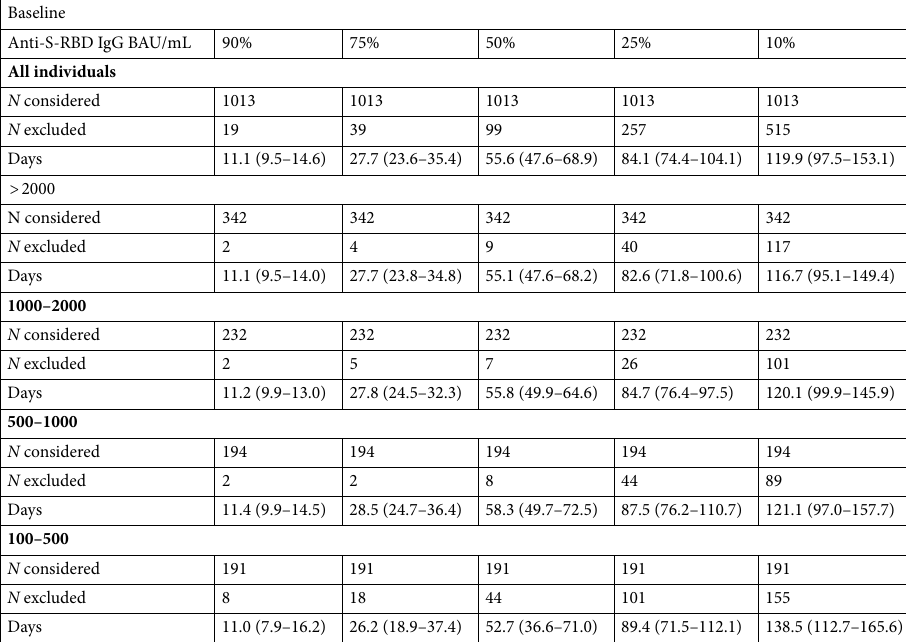
Table 1. % Residual IgG anti-S-RBD reactivity. Each cell reports the numbers of individuals considered for the analysis, the number of individuals excluded from the analysis since the reactivity at the last timepoint was still higher and the descriptive statistics expressed as median and interquartile (IQR).